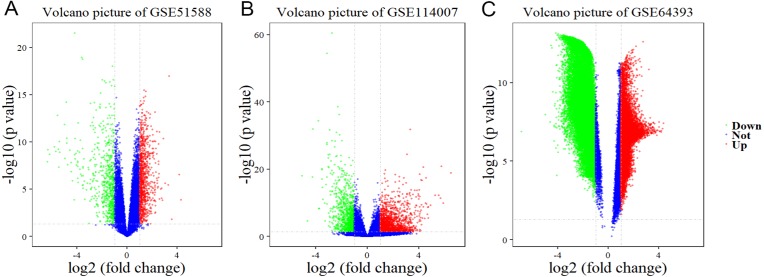
Differential gene expression and differential gene hydroxymethylation.(A) GSE51588 microarray dataset. (B) GSE114007 mRNA expression profile dataset. (C) GSE64393 high-throughput hydroxymethylation dataset. Red indicates upregulation, green indicates downregulation, and blue indicates no significant change in gene expression or hydroxymethylation based on the criteria of an absolute log2 (fold change) >1 and P < 0.05.